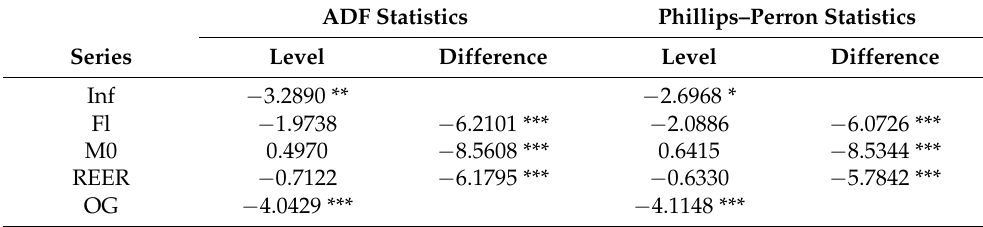
Table 4. Unit root test